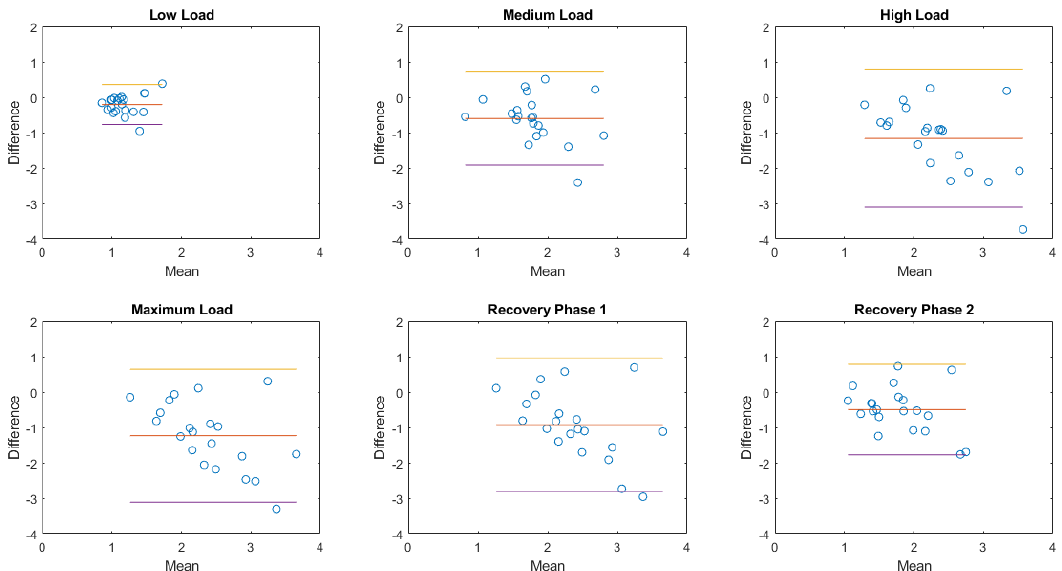
Figure 14. Bland–Altman plots of the aggregated results of respiratory rate at rest. Each dot represents the value obtained from a single subject. The yellow line represents the upper limit of agreement (mean error +1.96× standard deviation); the red line represents the mean error; the purple line represents the lower limit of agreement (mean error −1.96× standard deviation).